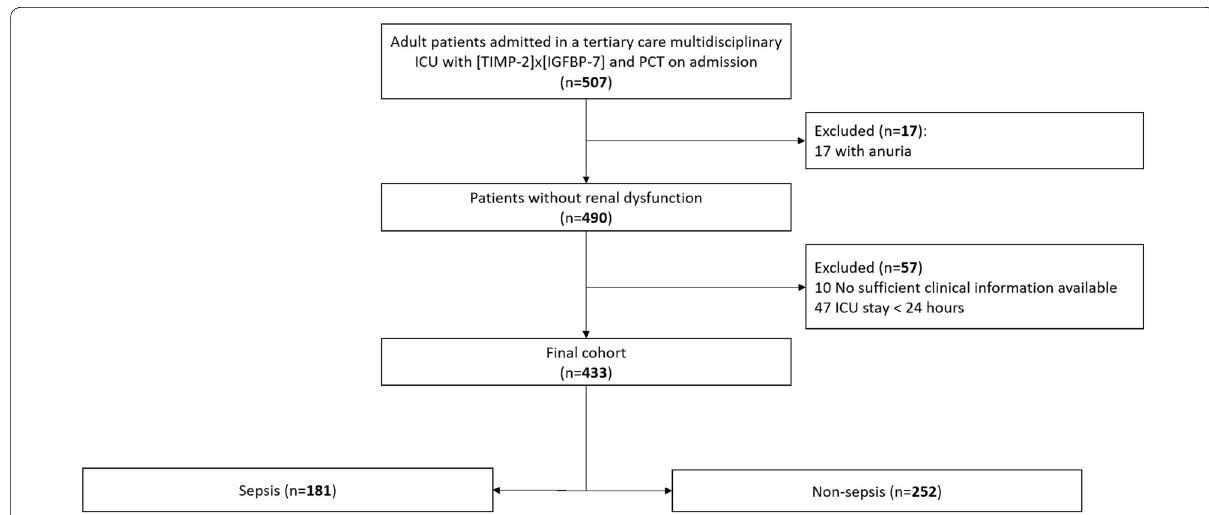
Fig. 1 Flowchart of study design. The chart shows patient inclusion and exclusion in the study analysis. ICU: intensive care unit; [TIMP-2] urinary tissue inhibitor of metalloproteinases-2 and insulin-like growth factor binding protein 7